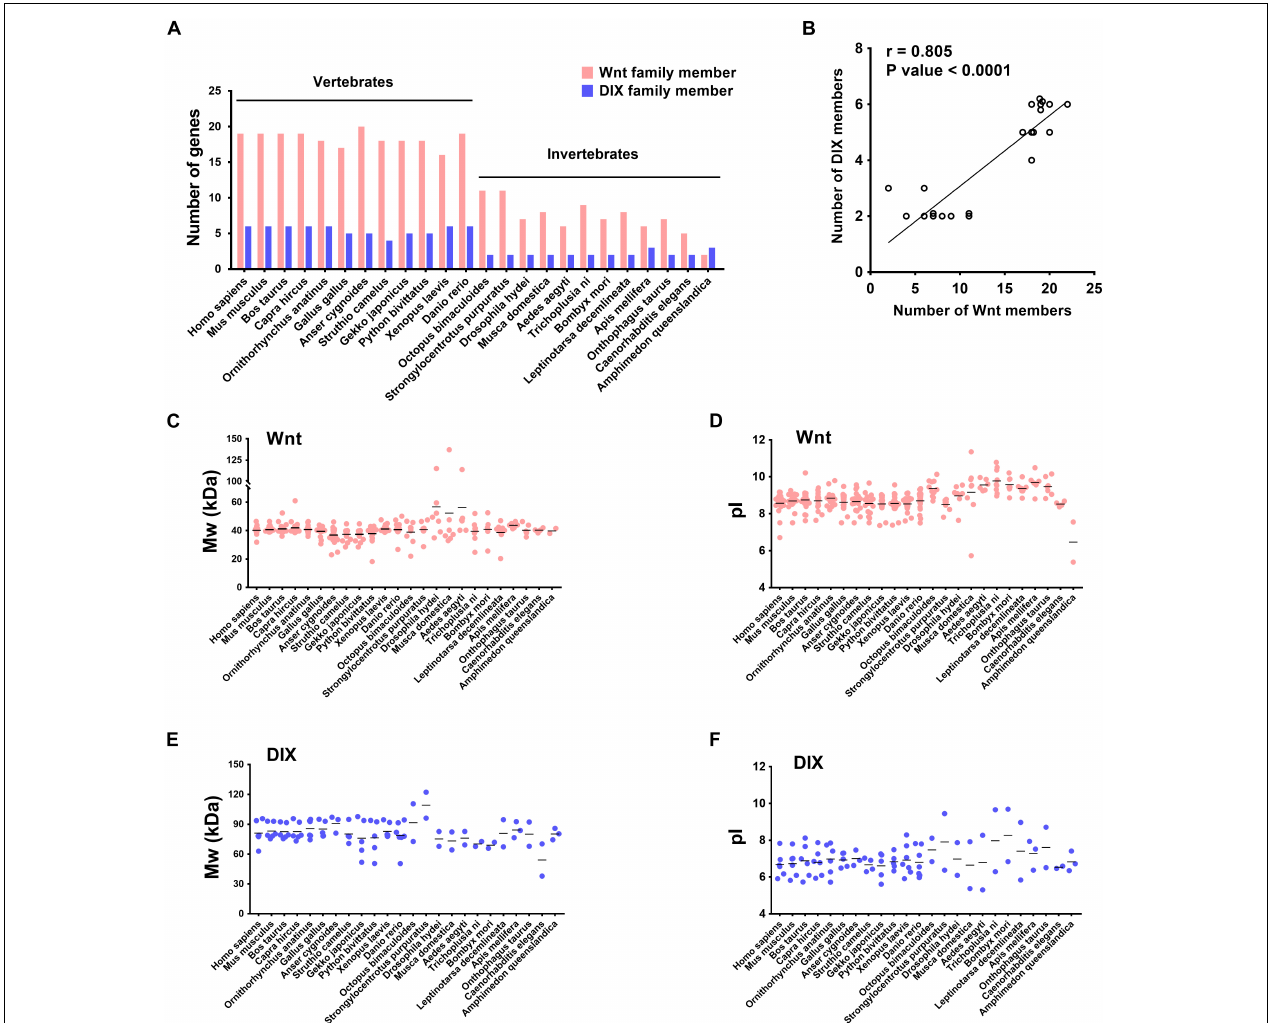
FIGURE 1 | The quantities and physicochemical characteristics of Wnt and DIX family members in different species. (A) The Wnt and DIX genes in 12 vertebrates and 12 invertebrates were identified. The number of Wnt genes in vertebrates (mean ∼ 18) is larger than that in invertebrates (mean ∼ 7). Similarly, the average number of DIX genes in vertebrates was 6, and in invertebrate, it was 2. (B) Pearson correlation of the number of the Wnt and DIX genes in the process of species evolution. Molecular weight distributions of Wnt proteins (C) and DIX protein (E) from different species. Isoelectric point (pI) distributions of Wnt proteins (D) and DIX proteins (F) from different